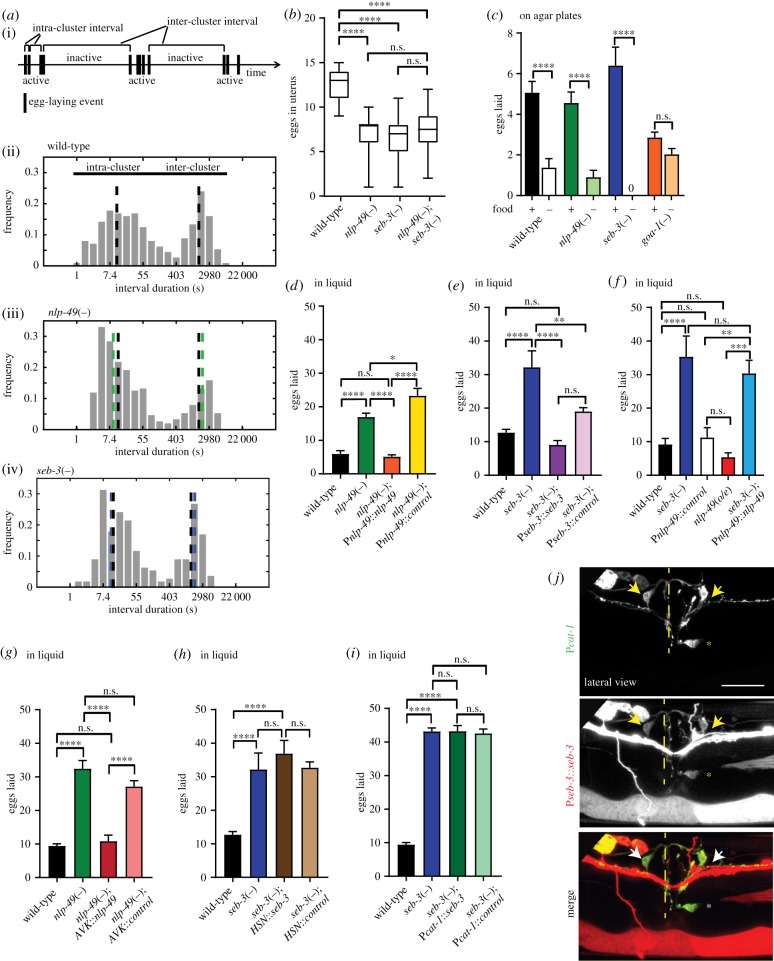
(Overleaf.) nlp-49 and seb-3 regulate egg-laying behaviour. seb-3(tm1848) is referred to as seb-3(−) and nlp-49(gk546875) as nlp-49(−). (a)(i) Representative temporal pattern for egg-laying showing active phases during which eggs are laid, interspersed by longer inactive phases. The time between egg-laying events during the active phase is the inter-cluster time, and the time between active phases is the intra-cluster time; (ii) histogram of interval times between egg-laying events for wild-type animals, with the interval duration in log scale. The location of the two peaks indicated by black dashed lines corresponds to the intra-cluster and inter-cluster time constants, estimated using maximum-likelihood analysis [44]; (iii) interval times between egg-laying events for nlp-49(−) animals; (iv) interval times between egg-laying events for seb-3(−) animals. Intra- and inter-cluster time constants for mutants are indicated in green (nlp-49(−)) or blue (seb-3(−)), with wild-type shown in black for comparison. See also table 1. (b) Eggs retained in the uterus for wild-type, nlp-49(−), seb-3(−) and seb-3(−);nlp-49(−) animals, at 16 h post-L4. 3 replicates, n > 15 per replicate. The box-and-whisker plot shows the box extending from the 25th to the 75th percentile, the line in the middle indicating the median. Whiskers extend from minimum to maximum. (c) Eggs laid on agar plates in the presence or absence of food (indicated by + or − beneath the graph) for wild-type, nlp-49(−) and seb-3(−) mutant animals, with goa-1 mutants as a positive control. n = 3 replicates, n = 12 per condition per replicate. Eggs laid in liquid (average for 10 worms) for (d) wild-type, nlp-49(−), and nlp-49 mutants expressing a rescue transgene for nlp-49 expression under its own promoter or a control mKate2 transgene; (e) wild-type, seb-3(−), and seb-3 mutants expressing a rescue transgene for seb-3 expression under its own promoter or a control mKate2 transgene; (f) wild-type, seb-3 mutants, animals overexpressing nlp-49 under its own promoter or a control mKate2 transgene, and animals overexpressing nlp-49 in a seb-3(−) background; (g) wild-type, nlp-49(−), and nlp-49 mutants containing a transgene for nlp-49 expression in AVK (Pflp-1) or a control mKate2 transgene; (h) wild-type, seb-3(−), and seb-3 mutants expressing seb-3 in HSN (Pegl-6) or a control mKate2 transgene; (i) wild-type, seb-3(−), and seb-3 mutants expressing seb-3 using a cat-1 promoter or a control gfp transgene. (j) Micrographs showing co-localization of Pseb-3::seb-3::SL2-mKate2 with cat-1-positive cells. The position of the vulval slit is indicated by the dashed line. HSN is shown by the asterisk and VC4/VC5 are indicated by arrows. Scale bar, 20 µm. For egg-laying assays in liquid (d–i), eggs were counted after 60 min, error bars indicate mean ± s.e.m., n > 3 replicates, n = 60 per genotype. Statistical tests: one-way ANOVA, Sidak's post-test. p-values indicated by n.s., not significant, * < 0.05, ** < 0.01, *** < 0.001 and **** < 0.0001.